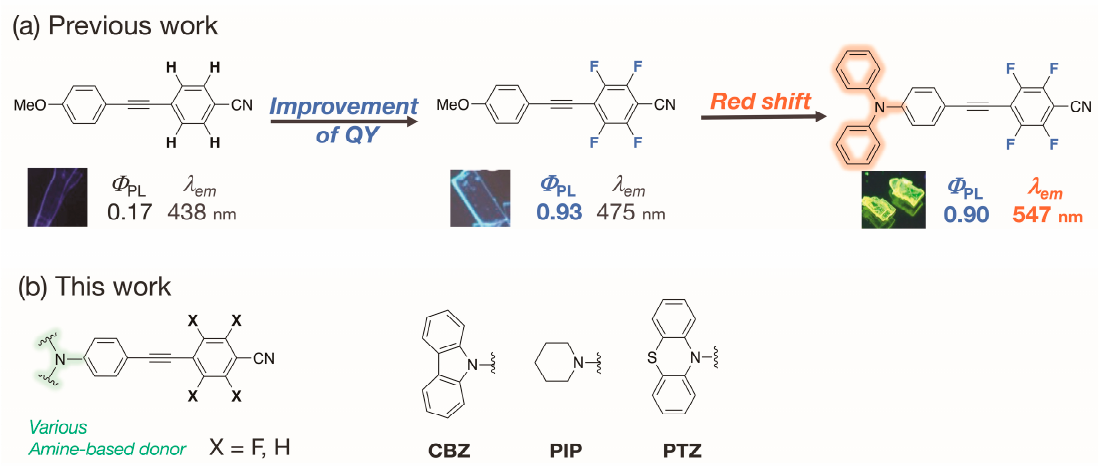
Figure 1. ( a ) Changes in the photoluminescence (PL) behavior of tolanes based on structural modula- tions. ( b ) Chemical structure of a fluorinated tolane with an amine-based donor used in this